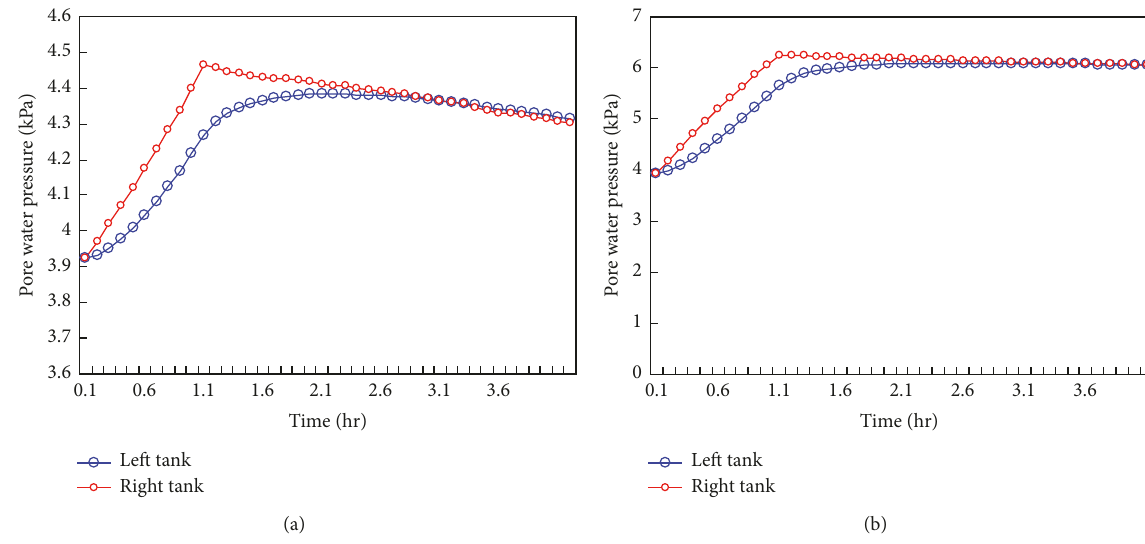
Figure 11: Monitoring data of numerical model (fine materials): (a) 45 mm/hr rainfall intensity and (b) 65 mm/hr rainfall intensity.